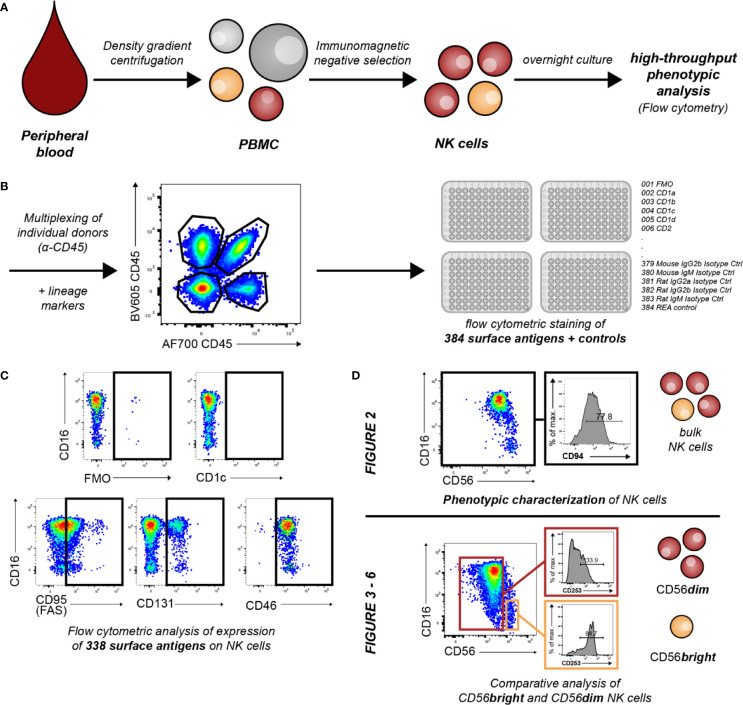
Overview of workflow and conducted experiments. (A) Primary human NK cells from peripheral blood of healthy donors were enriched by density gradient centrifugation and subsequent immunomagnetic negative selection. Enriched cells were cultured overnight in low-dose IL-2 (50 U/ml) and IL-15 (5 ng/ml). (B) For flow cytometric identification and purity assessment of NK cells, cells were stained for the expression of the lineage markers CD3, CD14, CD19, CD16, and CD56. For further discrimination of educated and uneducated sub-populations, NK cells were additionally labeled with antibodies against NKG2A, KIR3DL1, KIR2DL1, and KIR2DL2/L3. NK cells from up to four individual donors were subsequently multiplexed for further NK-cell phenotyping using α-hCD45. Multiplexed NK cells were stained with 384 antibodies and controls against surface antigens (n = 18). (C) Controls and surface antigens used for identification of NK cells and their subsets were excluded from further analysis. Therefore, expression of 338 surface antigens was assessed on NK cells. Exemplary dot plots show differential patterns of expression. (D) Downstream analyses focused on phenotypic characterization of NK cells and assessment of inter-individual variability in surface expression (Figure 2) as well as phenotypic differences between CD56bright and CD56dim NK cells (Figures 3–6).